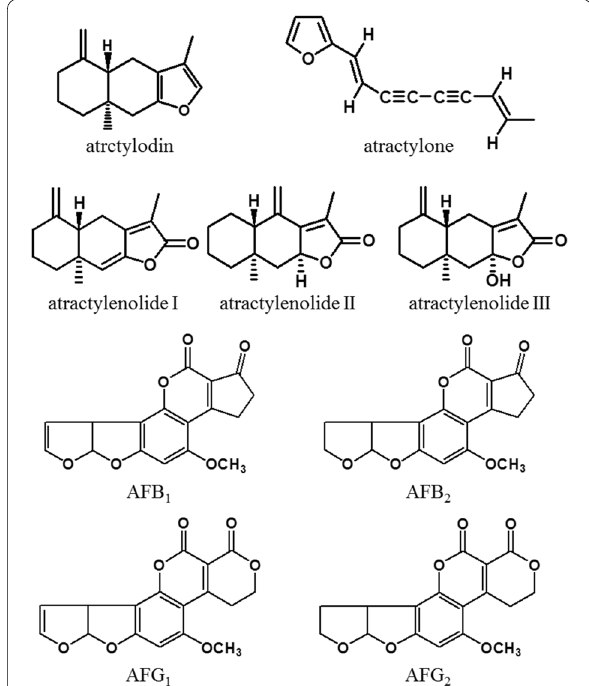
Fig. 1 Chemical structures of 5 chemical components in A.